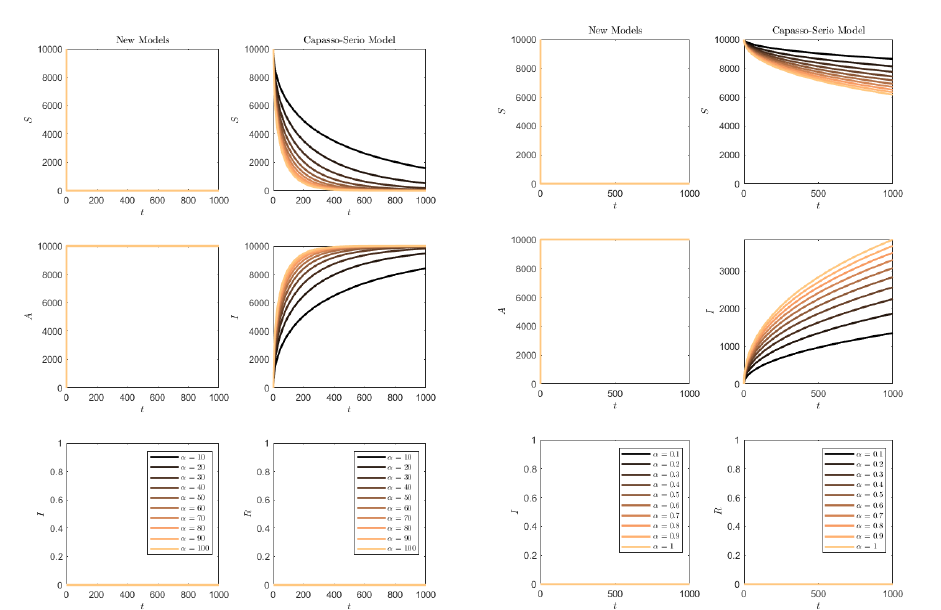
Figure 13. Here, π = γ = 0, so that both systems become SI models. Comparison between (1) (or, equivalently, (23)) on the left column, and the Capasso–Serio model (73), on the right column. Left frame: α ∈ [ 10, . . . ,100 ] . Right frame: α ∈ [ 0.1, . . . ,1.0 ] . The other parameter values are given in (74) and initial conditions